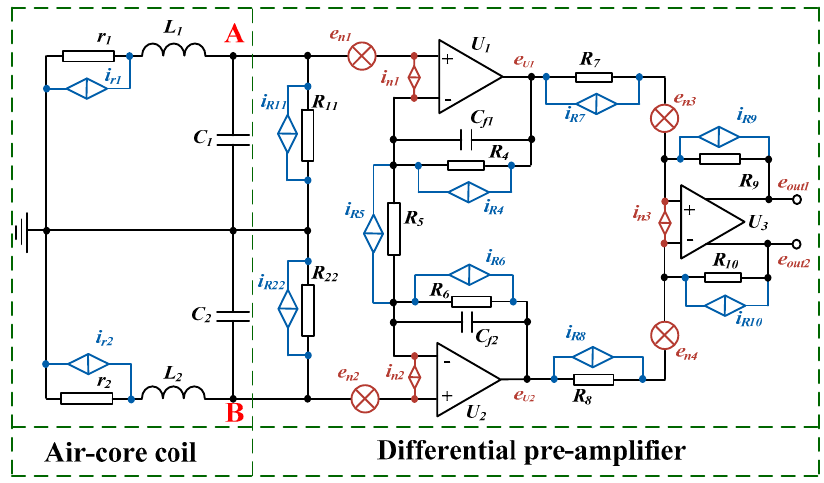
Figure 5. Equivalent schematic of ACS with pre-amplifier circuit.